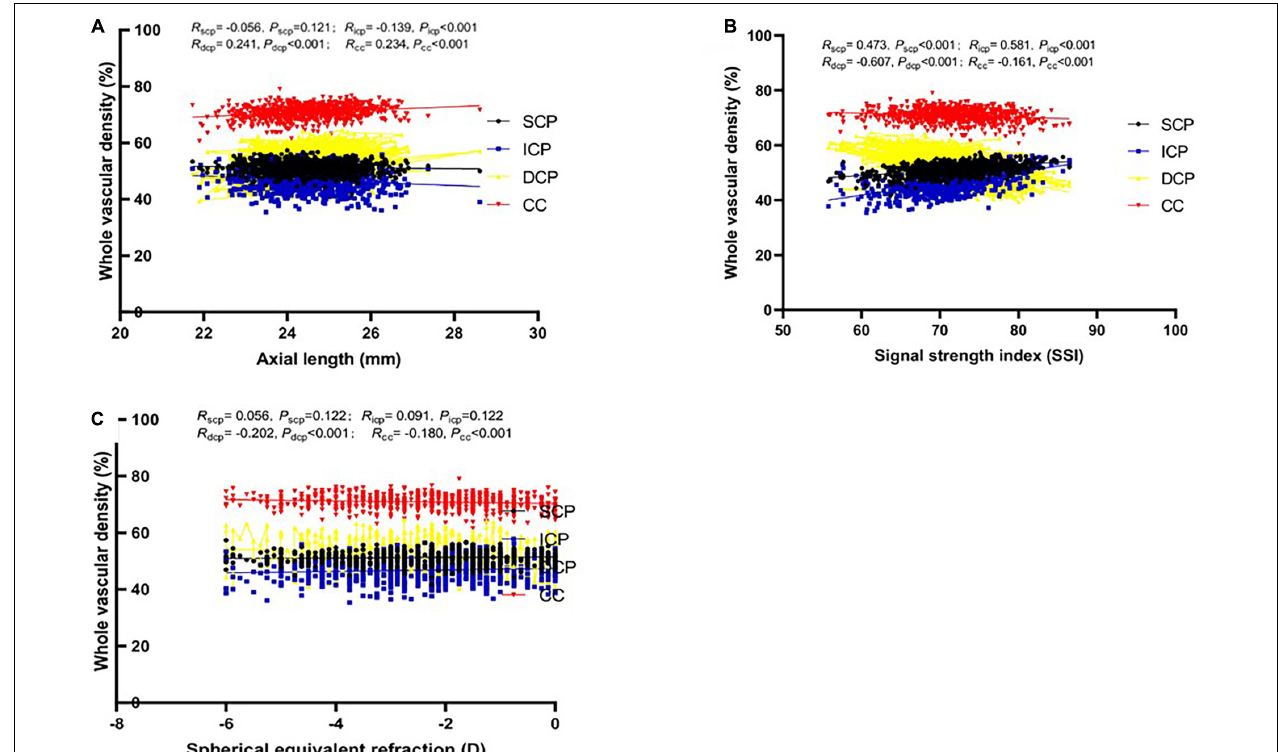
FIGURE 1 | Relationship between vascular density (VD) in whole macular retina and axial length (mm) in four different vascular plexuses (SCP: superficial capillary plexus; ICP: intermediate capillary plexus; DCP: deep capillary plexus; CC: choriocapillaris). Boxes and lines of black, blue, yellow and red color depict the relationship between the possible influencing factors [ (A) Axial length; (B) Signal strength index; (C) Spherical equivalent refraction] and VD in SVP, DVC, ICP, and DCP, respectively.